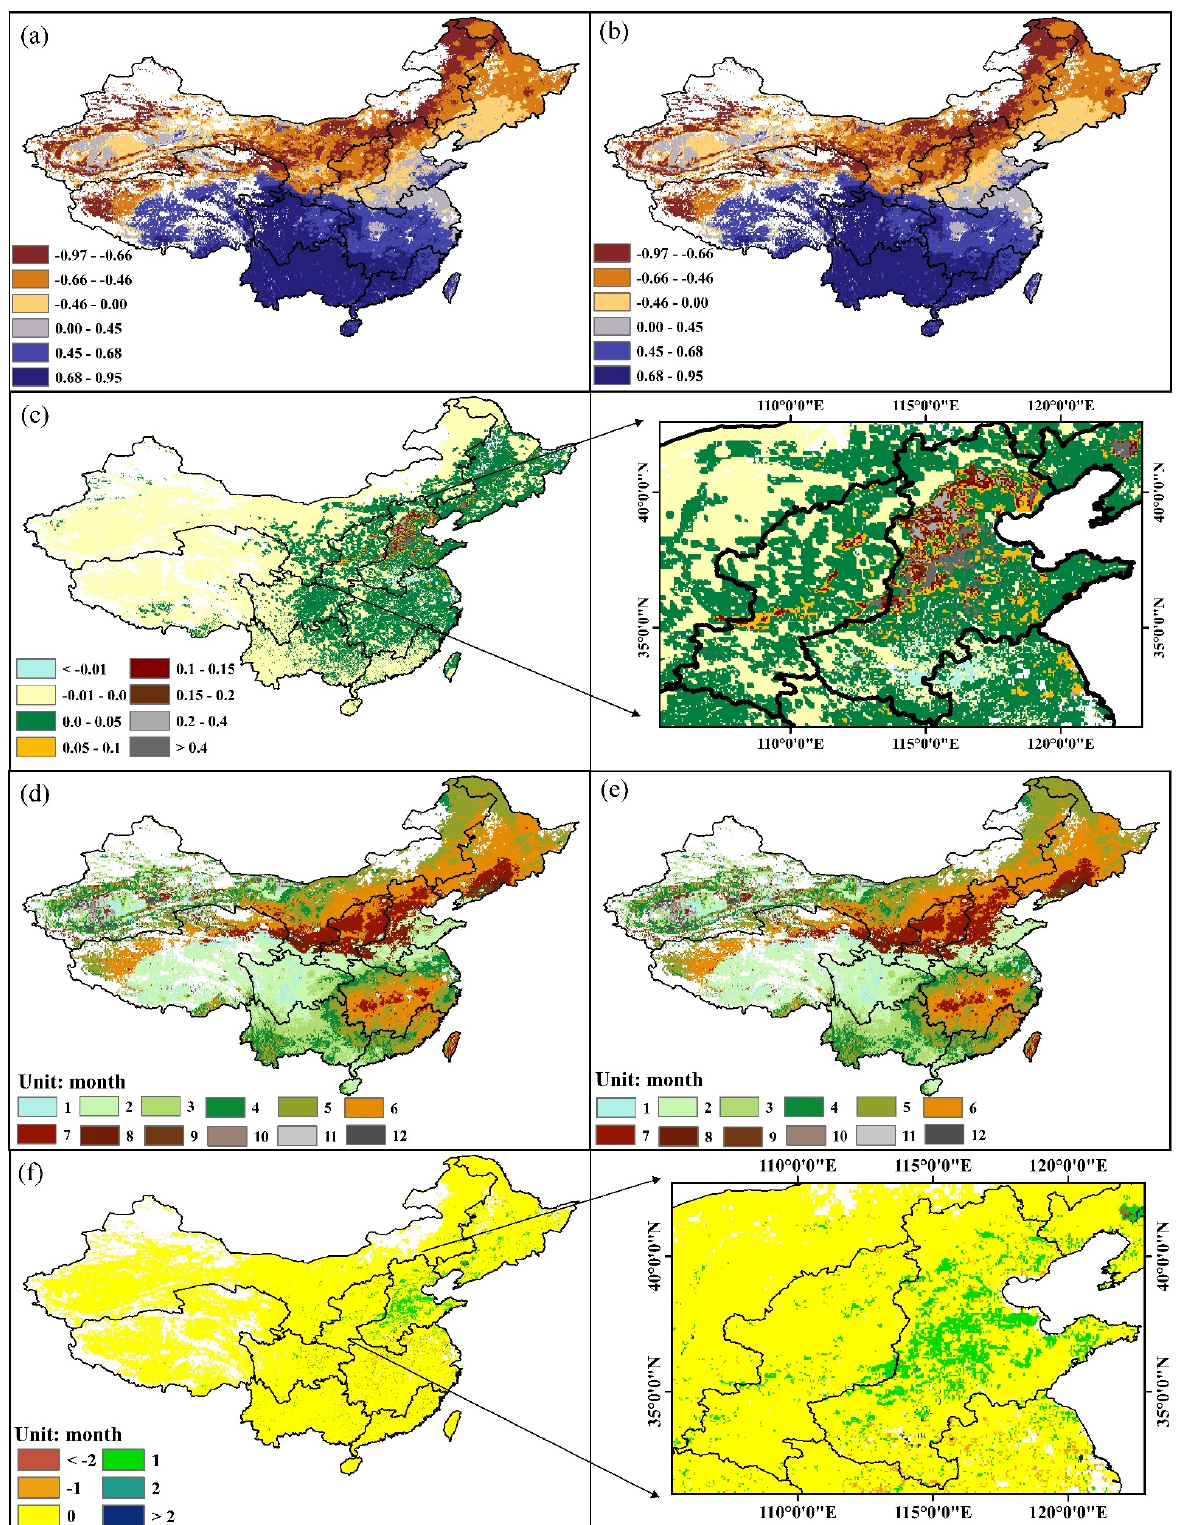
Figure 4. Vegetation response degree to the SPEII ( a ) and SPEI ( b ). The difference value between the vegetation response degree to the SPEII and SPEI ( a minus b ) ( c ). Vegetation response time to the SPEII ( d ) and SPEI ( e ). The difference value between the vegetation response times to the SPEII and SPEI ( d minus e ) ( f